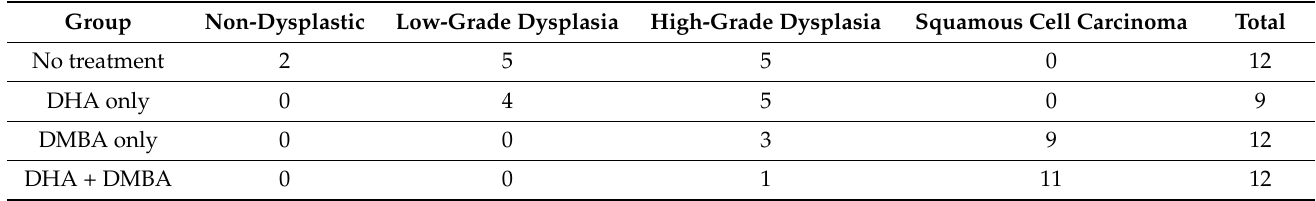
Table 1. Anal disease incidence in K14E6/E7 transgenic mice. Chi-square analysis and Fisher’s exact tests were performed, comparing no treatment to DHA only and DMBA only to DHA + DMBA. There were no statistically significant differences in final anal histology between treatment groups.